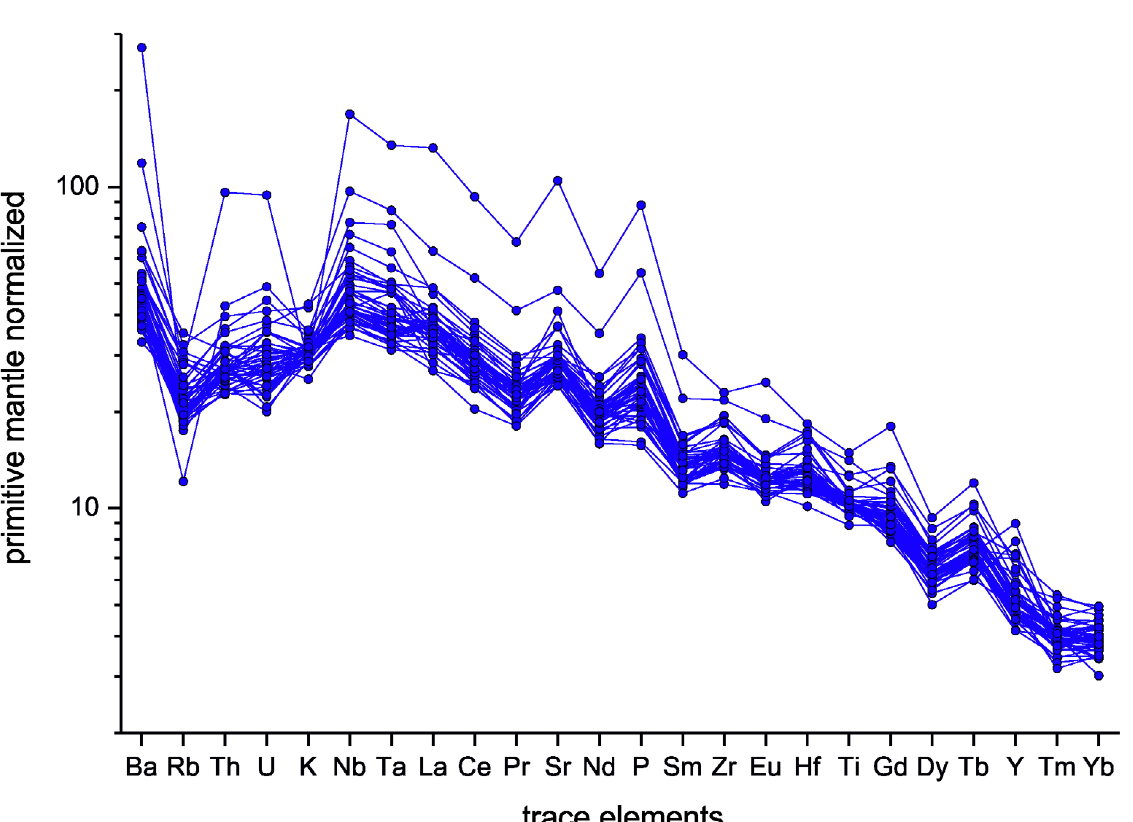
Figure 5. Primitive mantle-normalized trace element diagram. Primitive mantle-values taken from McDonough and Sun